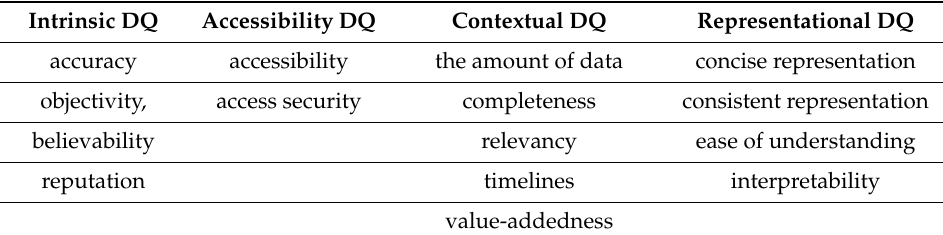
Table 1. Data quality